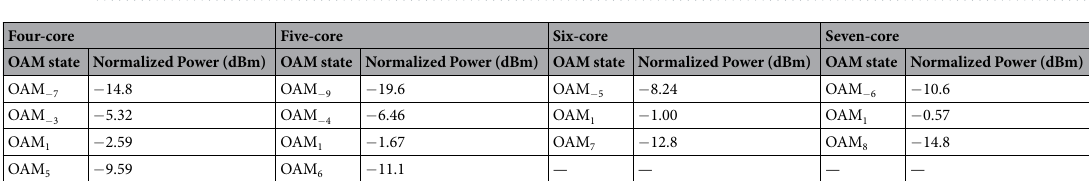
Figure 5. OAM multicasting with different N . ( a ) OAM spectrum in four-core supermode fiber. ( b ) OAM spectrum in five-core supermode fiber. ( c ) OAM spectrum in six-core supermode fiber. ( d ) OAM spectrum in seven-core supermode fiber. Normalized power weight under blue line may be not suitable for carrying data.